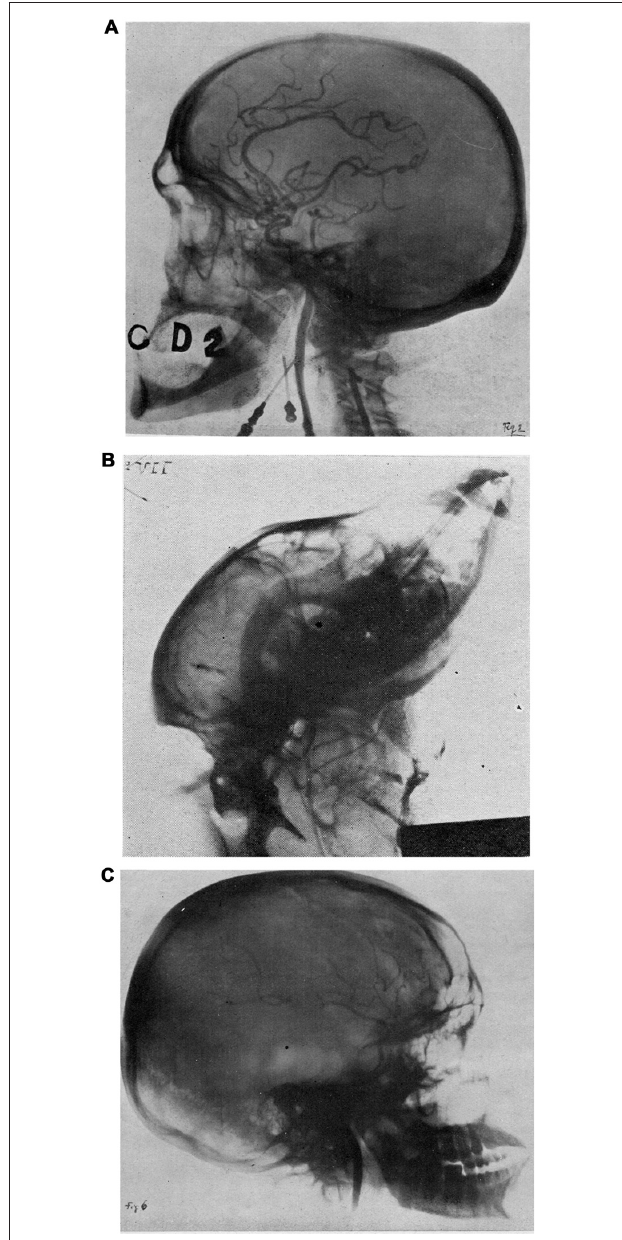
FIGURE 2 | (A) The arterial network arising from the internal carotid artery, as visualized following the injection of 30% sodium iodide (NaI) in a formalin-fixed head (from “ L’encéphalographie artérielle, son importance dans la localization des tumeurs cérébrales ”, Egas Moniz (de Lisbon), Société de Neurologié, séance du 7 Juillet 1927; Revue Neurologique, T. II, Figure 2, n ◦ 1 Juillet, 1927). (B) The visualization of some cerebral arteries in a living dog (from “ L’encéphalographie artérielle, son importance dans la localization des tumeurs cérébrales ”, Egas Moniz (de Lisbon), Société de Neurologié, séance du 7 Juillet 1927; Revue Neurologique, T. II, Figure 5, n ◦ 1 Juillet, 1927). (C) First successful “arterial encephalography” in a 20 year-old man with